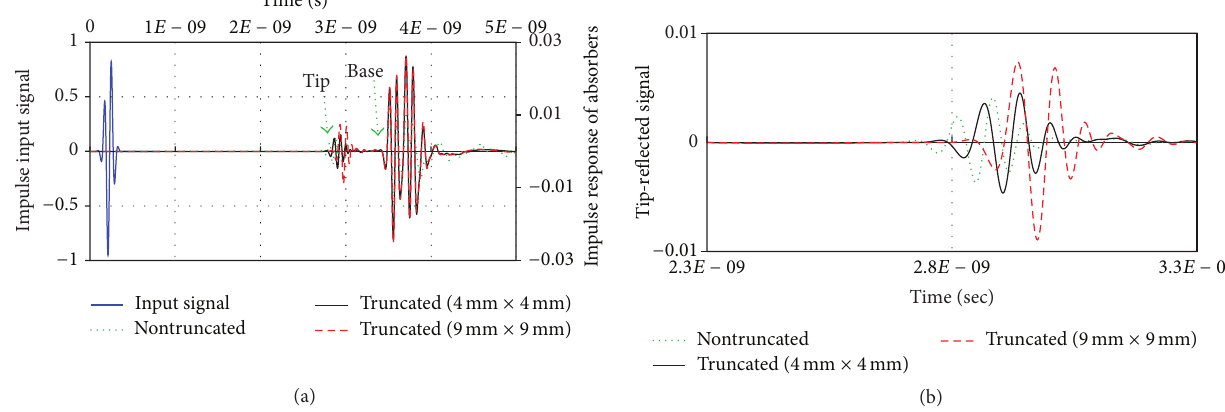
Figure 11: Time domain wave-absorber interaction and effect of truncated tips. (a) Overall impulse response of the wave-absorber system; (b) signals that were reflected from the tips.